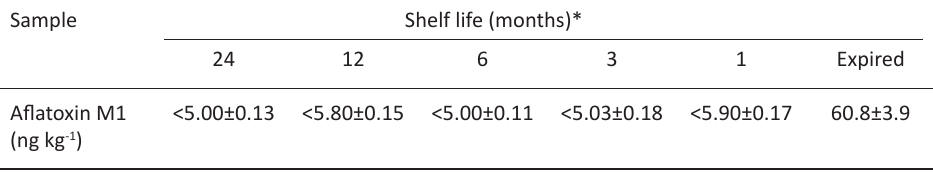
Table 2. Level of aflatoxin M1 in infant milk powder with different duration of expiry Sample